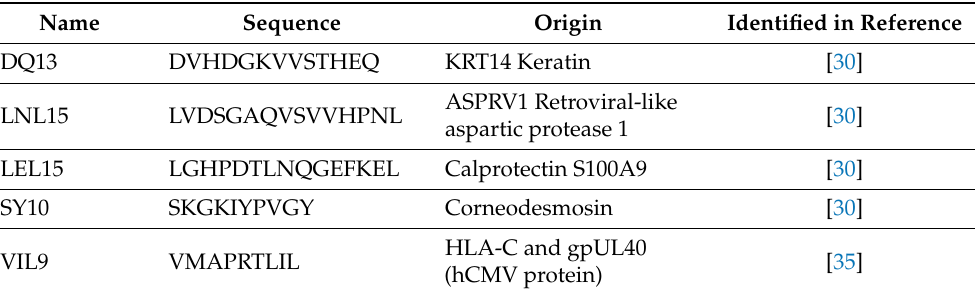
Table 1. Non-canonical HLA-E peptide ligands.